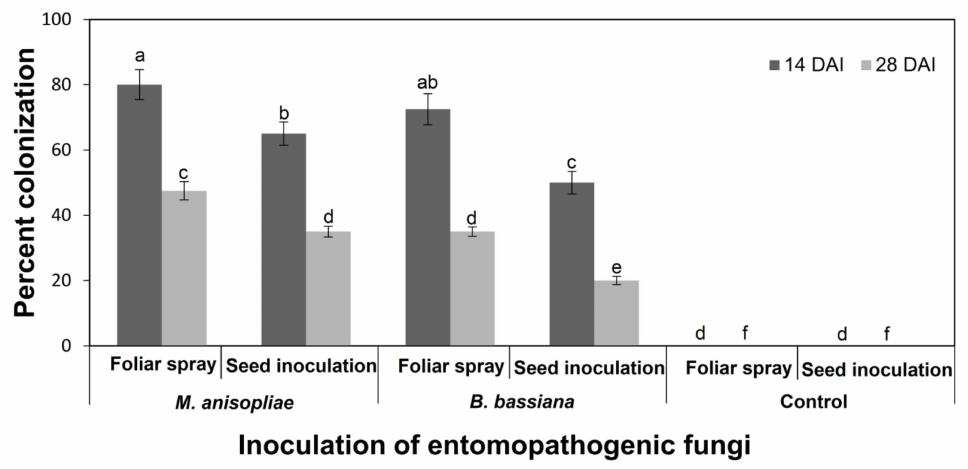
Figure 1. Percent colonization (means ± SE) of entomopathogenic fungi on maize with two inocula- tion methods at 14 and 28 days after inoculation (DAI) (LSD test after three-way ANOVA). Different letters above bars indicate significantly different